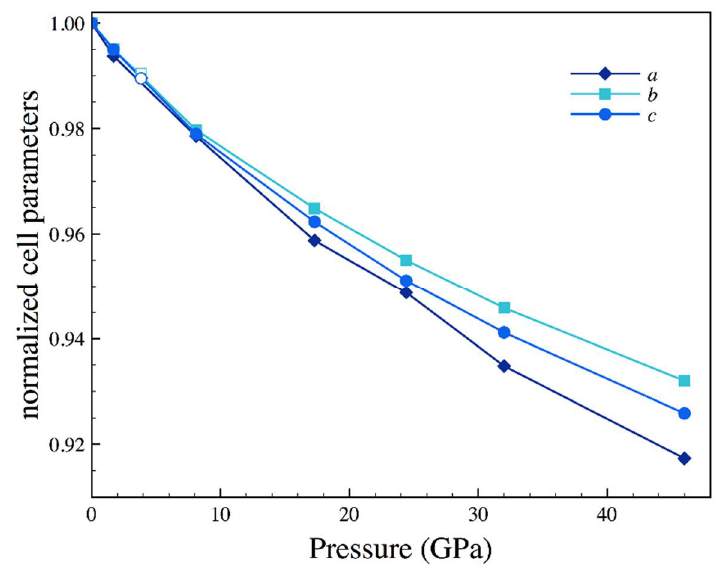
Figure 4. Bulk compressibility of FeSe 2 . The blue symbol shows data collected at ambient pressure in DAC and cryostat. The blue line shows a second order Birch–Murnaghan EoS fit, the red line a third order Birch–Murnaghan EoS fit (see text).